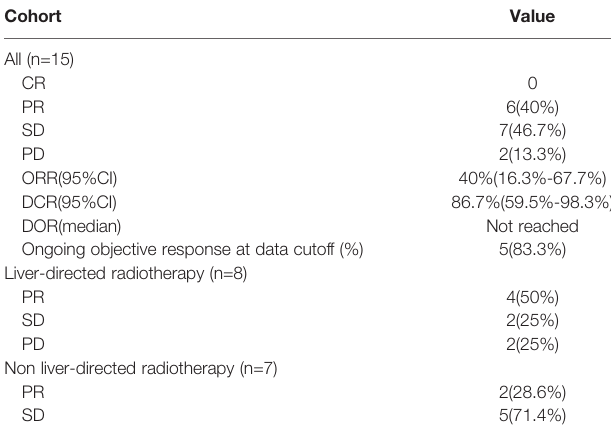
TABLE 5 | Response